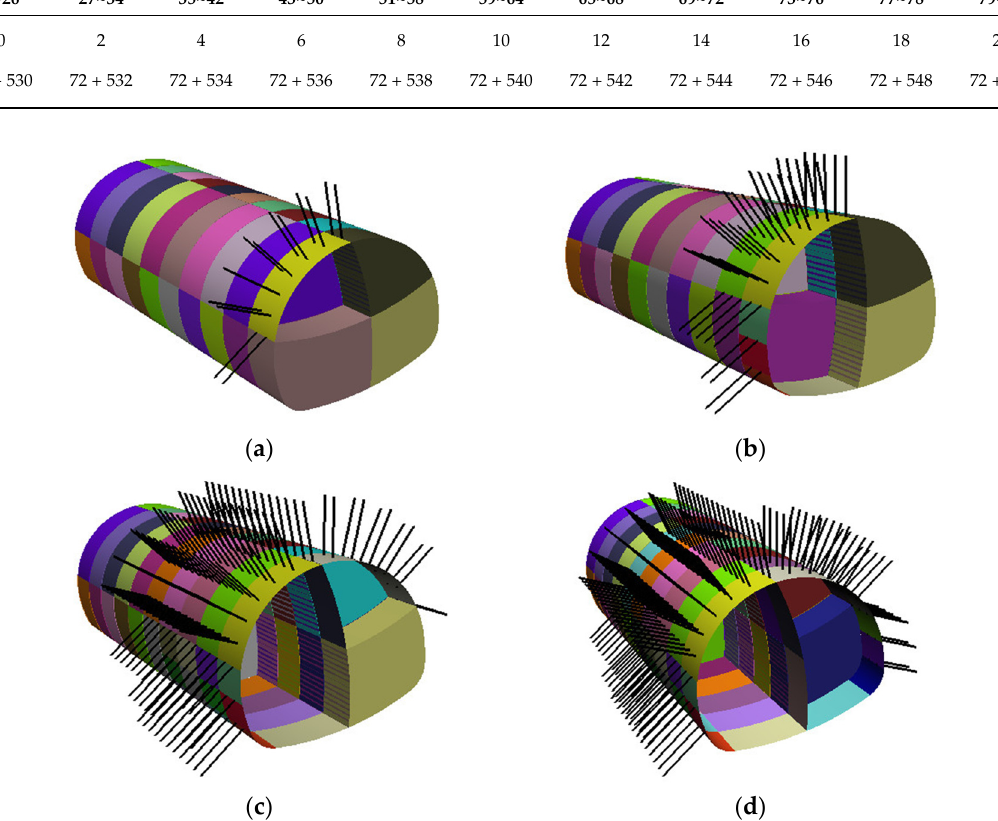
Figure 5. Primary support under the excavating process. ( a ) part I (step 2); ( b ) part II (step 6); ( c ) part III (step 20); ( d ) part IV (step 28).